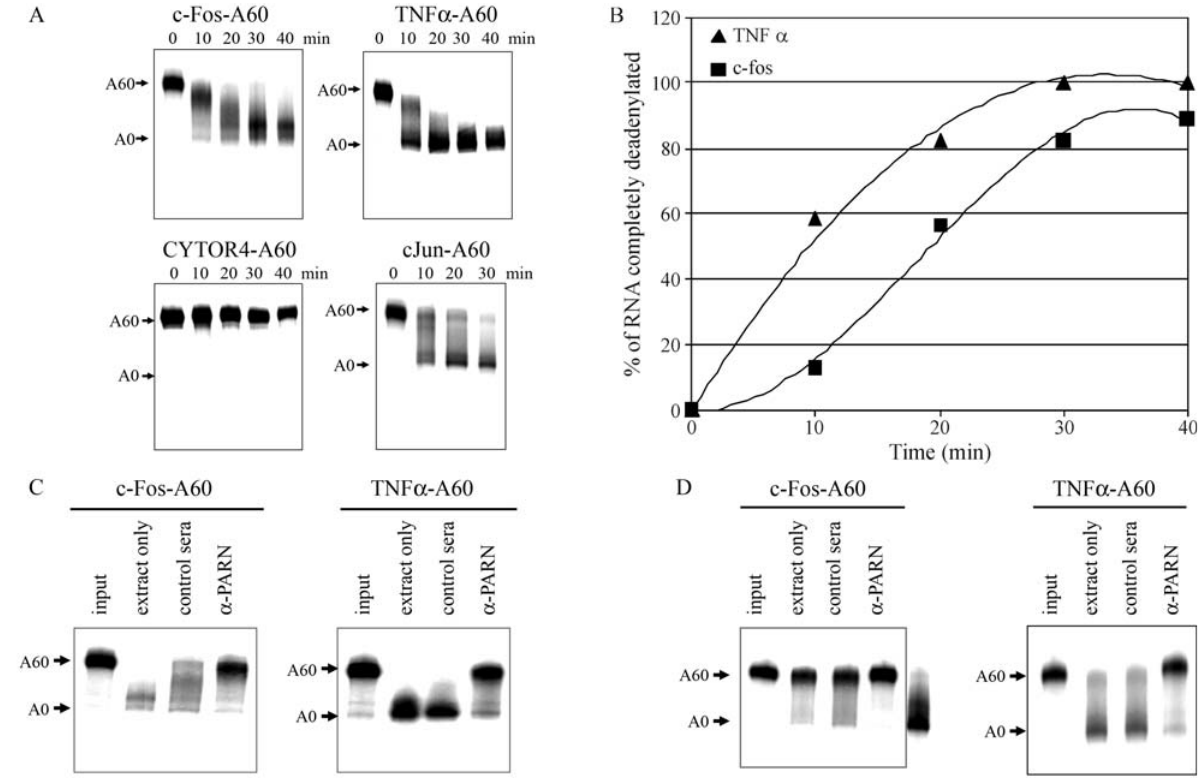
Figure 1 - Three main patterns of deadenylation can be observed on RNA substrates that contain AU-rich elements in HeLa extracts. Panel 1A. pGEM-4 plasmidscontaining250bpinsertsofthe3’UTRsurroundingtheAREelementsofrepresentativemembersofseveraldifferentsubclassesofAU-richele- ments were generated by RT-PCR. Capped and polyadenylated RNAs containing 250 base segments of the 3’UTR of cFos (cFos-A60), TNF α (TNF α -A60), CYTOR-4 (CYTOR4-A60) or cJun (cJun-A60) mRNA were incubated with HeLa cytoplasmic S100 extracts in an in vitro mRNA deadenylation/decay system for the times indicated. Reaction products were analyzed on 4% acrylamide gels containing 7 M urea and visualized by phosphorimaging. The positions of the adenylated (A60) and unadenylated (A0) RNAs are indicated to the left of each frame. Panel 1B. Graphical repre- sentation of the data obtained for cFos and TNF α in panel A. Panel C. Capped and polyadenylated RNAs containing 250 base segments of the 3’UTR of cFos (cFos-A60) or TNF α (TNF α -A60) mRNA were incubated in HeLa cytoplasmic extracts S100 extracts in an in vitro mRNA deadenylation/decay system for 0 time (input lanes) or 40 min (extract only lanes). Some extracts were treated with control rabbit serum (control serum lanes) or immunodepleted using PARN-specific antisera ( α -PARN lanes) prior to use in the assay as previously described (Gao et al. , 2000). Reaction products were analyzed on 4% acrylamide gels containing 7 M urea and visualized by phosphorimaging. The positions of the adenylated (A60) and unadenylated (A0) RNAs are indicated to the left of each frame. Panel D. Same as panel C, but Jurkat cytoplasmic extracts were used instead of HeLa cytoplasmic ex-